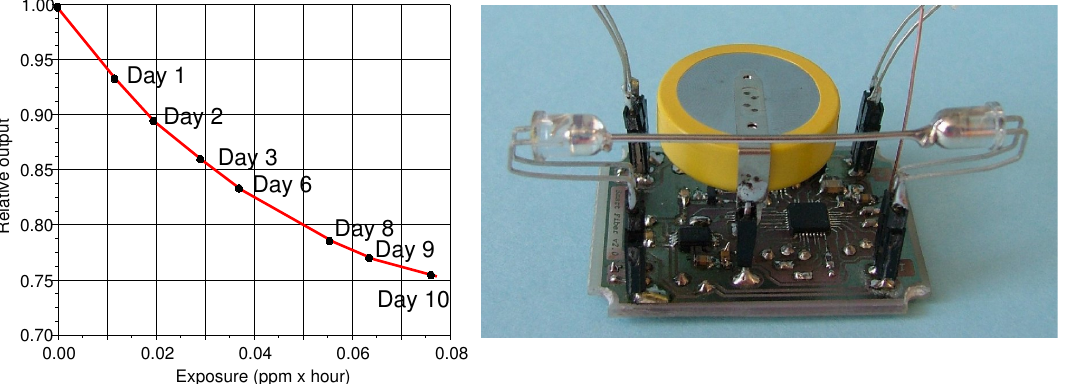
S exposure obtained according to the procedure Figure 7. ( Left ) The sensor response to H 2 previously described: each dot represents the transmittance value recorded at the end of each S gas injection; ( Right ) An example of the setup composed of the fiber-based day after an H 2 sensor and of the wireless communication